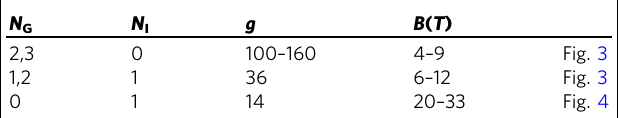
Table 1 Compilation of g values measured for degeneracy lifted states.